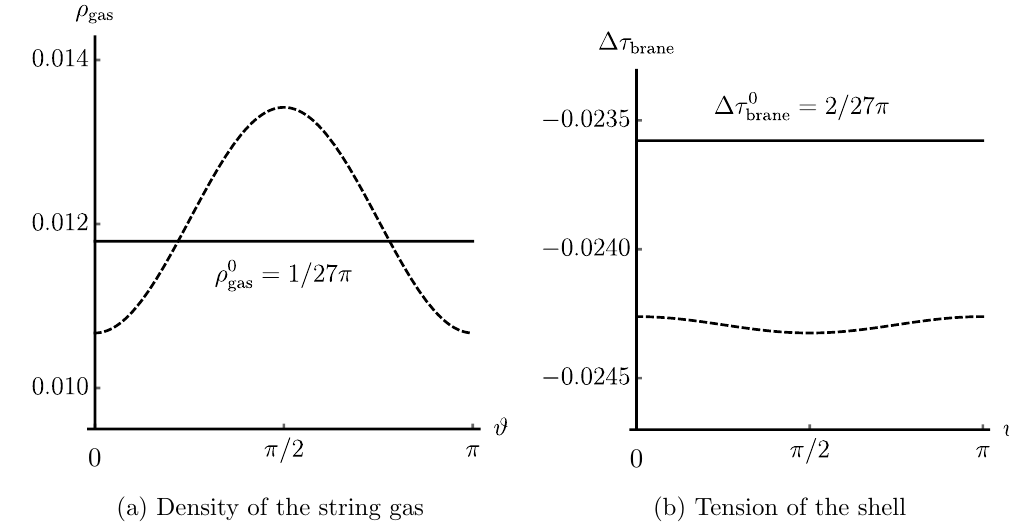
p Figure 1. Density of the gas and tension of the shell (apart from the k= 4 (cid:25) contribution) as a function of the angular variable # (for M = 1 ; a = 0 : 3) are plotted as dashed lines. Density is given by (cid:26) gas = 0 : 0118 (cid:0) a 2 (0 : 0212 + 0 : 106 n 1 + 0 : 0153 cos 2 # ) while the tension (cid:1) (cid:28) brane is given by p (cid:1) (cid:28) brane := (cid:28) (cid:0) k= 4 (cid:25) = (cid:0) 0 : 0236 + a 2 (0 : 00812 + 0 : 0707 n 1 + 0 : 000354 cos 2 # ). The straight lines show the corresponding values for a non-rotating shell. The density of the gas (and correspondingly the pressure) as well as the pressure due to the brane ( p = (cid:0) (cid:26) ) increases towards the equator causing a net increase in the pressure which provides the necessary centripetal force that holds the bubble together as it starts to